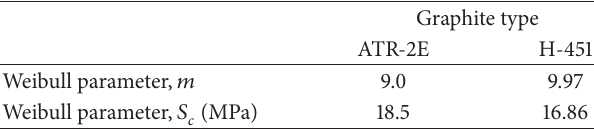
Table 2: Weibull parameters of ATR-2E and H-451 graphite.